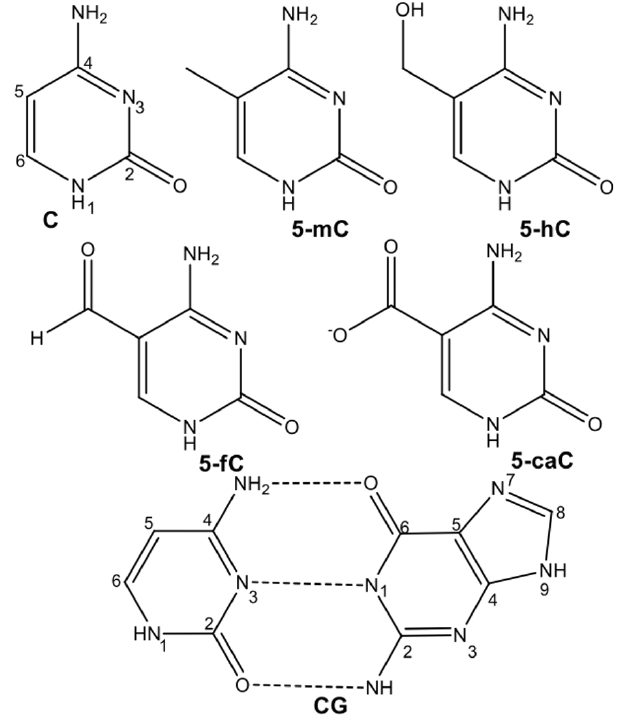
Figure 1. Structures of cytosine and its epigenetic